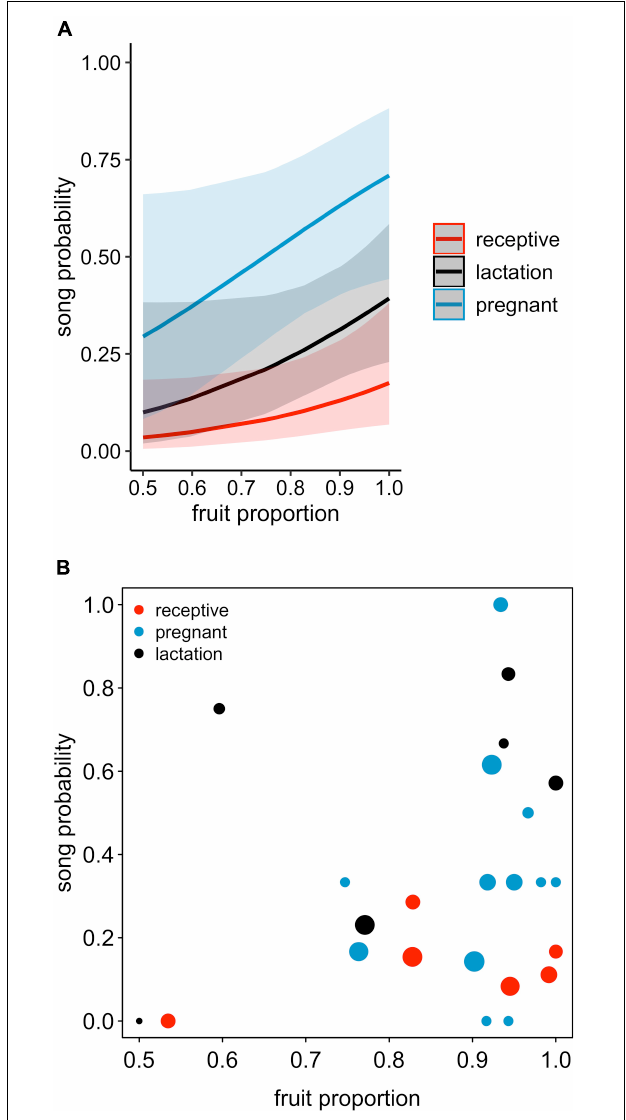
FIGURE 1 | (A) Song probability as a function of female reproductive state and proportion of feeding time allocated to fruits, shown separately for each female reproductive state. The lines depict the fitted model (based on group size at its average), and blue, black, and red areas show the corresponding 95% confidence intervals. (B) Proportions of singing days for different female reproductive states and different fruit proportions, with the area of the dots increasing linearly with the respective sample size (1 to 14 observation days per each combination of reproductive state and fruit proportion, total N = 171 observation days).